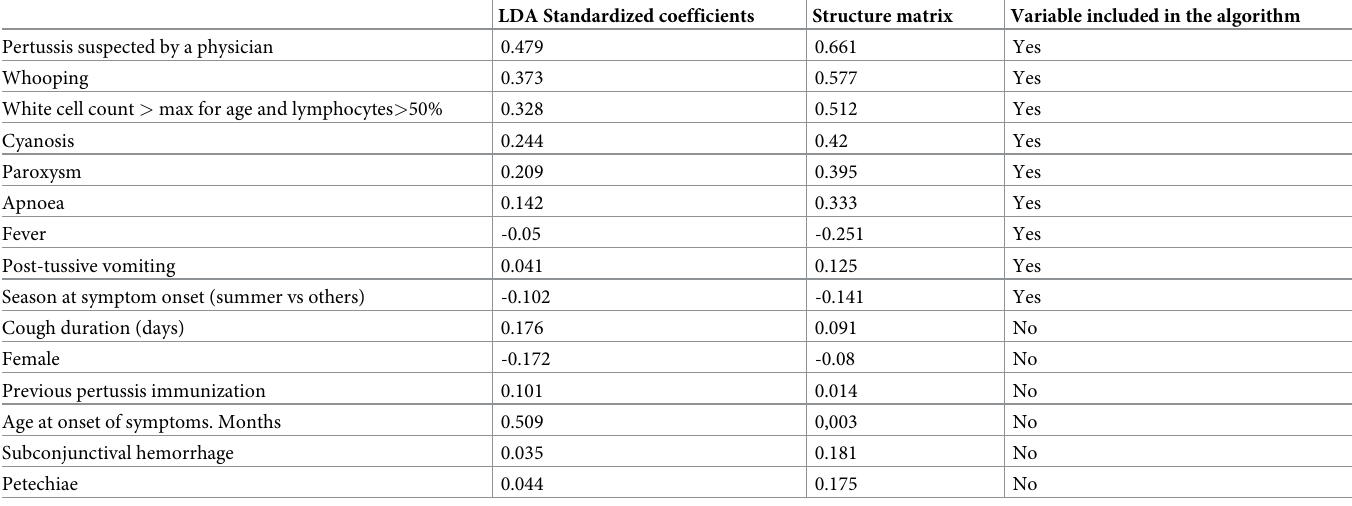
Table 3. Identification of variables to feed the algorithm through linear discriminant